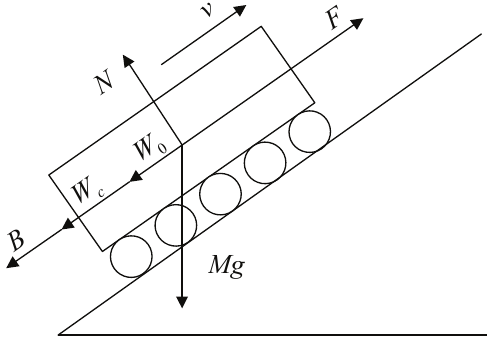
Figure 3. Force condition of urban rail train.